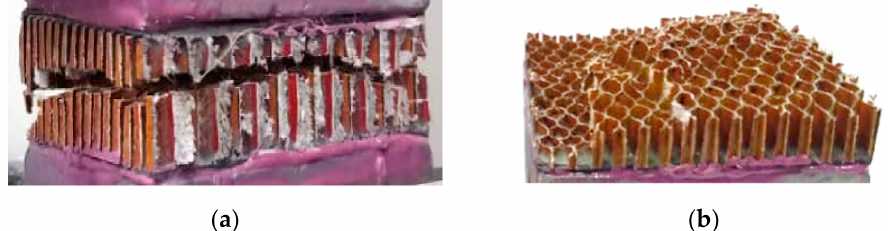
Figure 9. ( a ) Location of the fractured plane along the cell height, and ( b ) fractured surface of the polymer hexagonal HC core specimen, following the out-of-plane tensile